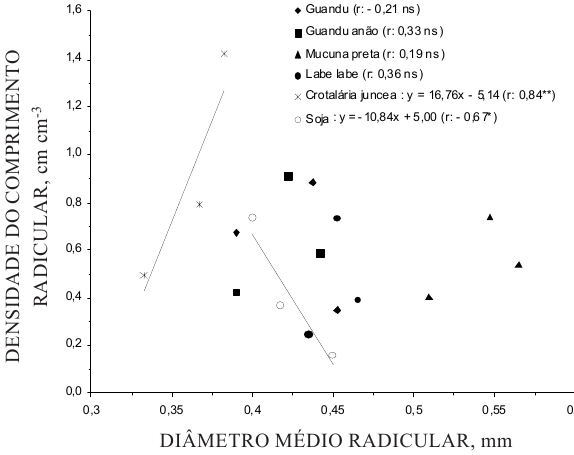
Figura 4. Correlação entre as variáveis diâmetro médio radicular e densidade do comprimento radicular das plantas de cobertura e da soja na camada de solo compactado. * e ** signifi- cativos a 5 e 1 % pelo teste t,